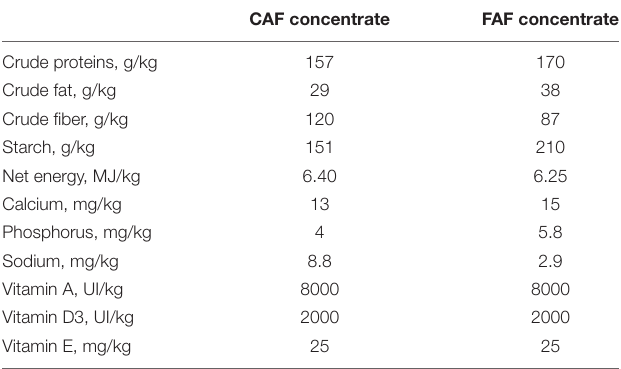
TABLE 1 | Nutritional composition (/kg) of commercial concentrates used during the CAF period (100% concentrates diet) and the FAF period (66% orchard hay